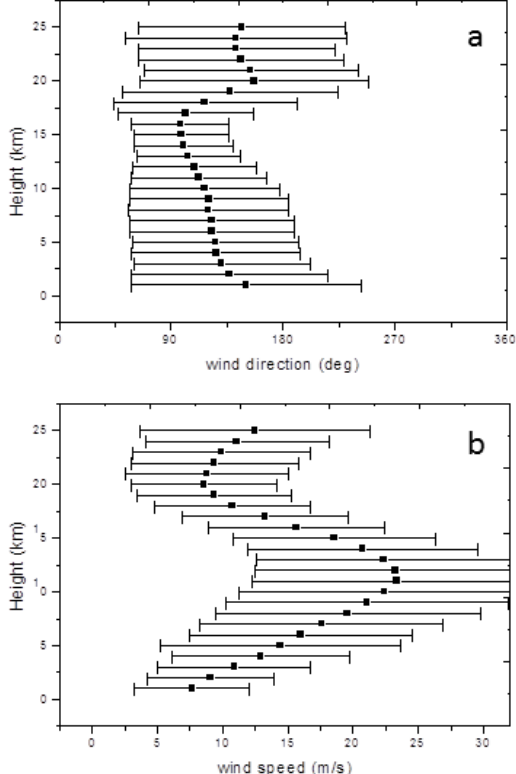
Fig. 6. Plots showing: (a) the mean wind direction (provenance + 180 ◦ ) and (b) the mean wind speed everykm over 15yr of wind profiles sampled 4 times a day (00:00; 06:00, 12:00, 18:00LT) from Figure 6. Plots showing: a) the mean wind direction (provenance +180°) and b) the mean 646 1 January 1990 up to 2003. The standard deviation for each height level is also reported. Data are available at wind speed every km over 15 years of wind profiles sampled 4 times a day (00:00; 06:00, 647 12:00, 18:00 local time) from 1 January 1990 up to 2003. The standard deviation for each 648 height level is also reported. Data are available at http://weather.uwyo.edu. 649